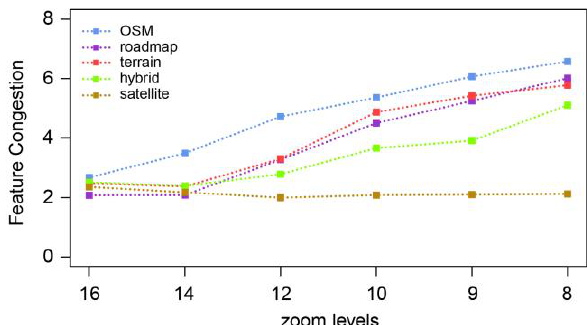
Figure 4. Mean Feature Congestion of geovisualizations types across examined zoom